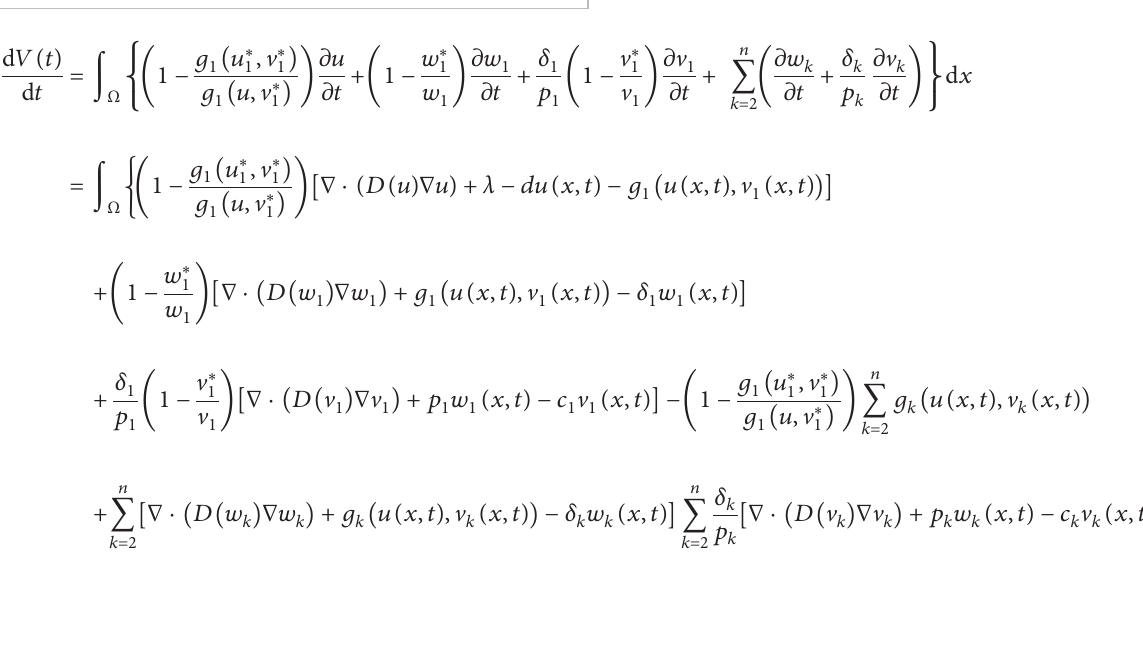
� m � m � 2, λ � 10, d � 0 . 09, β � 0 . 0005, δ � 0 . 4, c � 2 . 4, p � 300, a � 0 . 5, and b � 0 . 4, we have R 1 2 3 � ( 111 . 1111 , 0 , 0 ) of model (59) is globally asymptotically 0